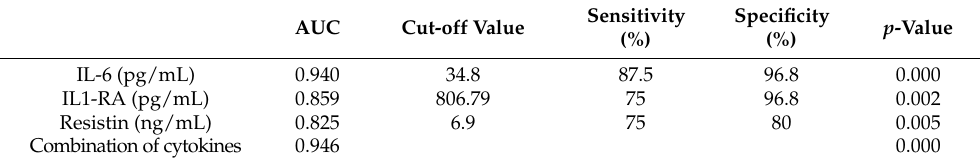
Table 5. ROC analysis -performance of LVR prediction using plasma cytokines.